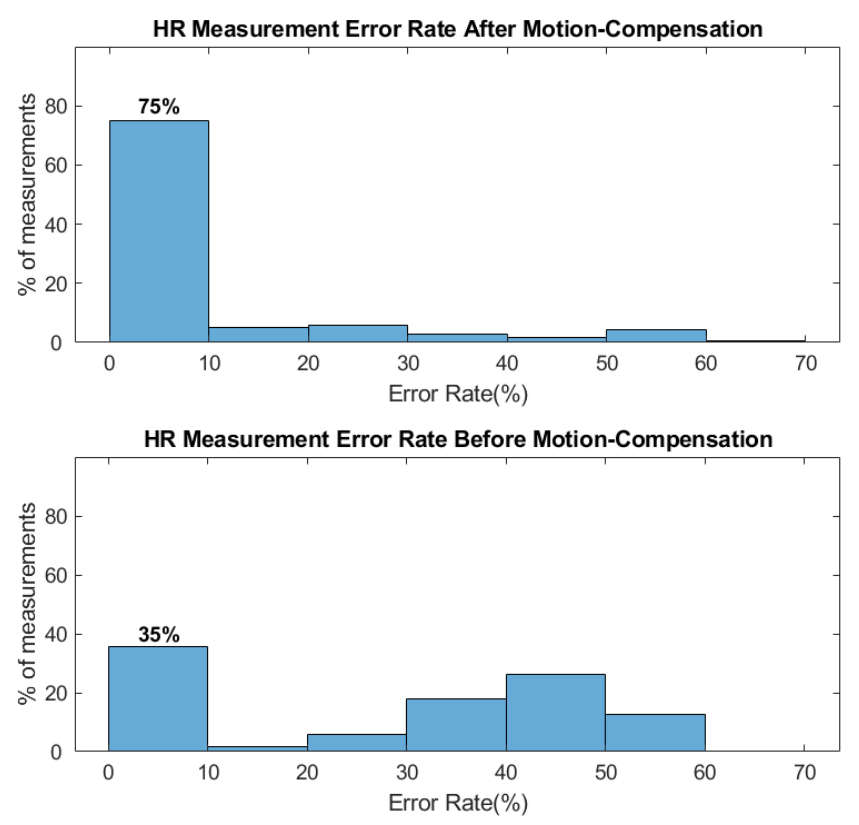
Figure 10. HR measurements error rate on all 286 measurements with motion compensation ( top ) and without motion compensation ( bottom